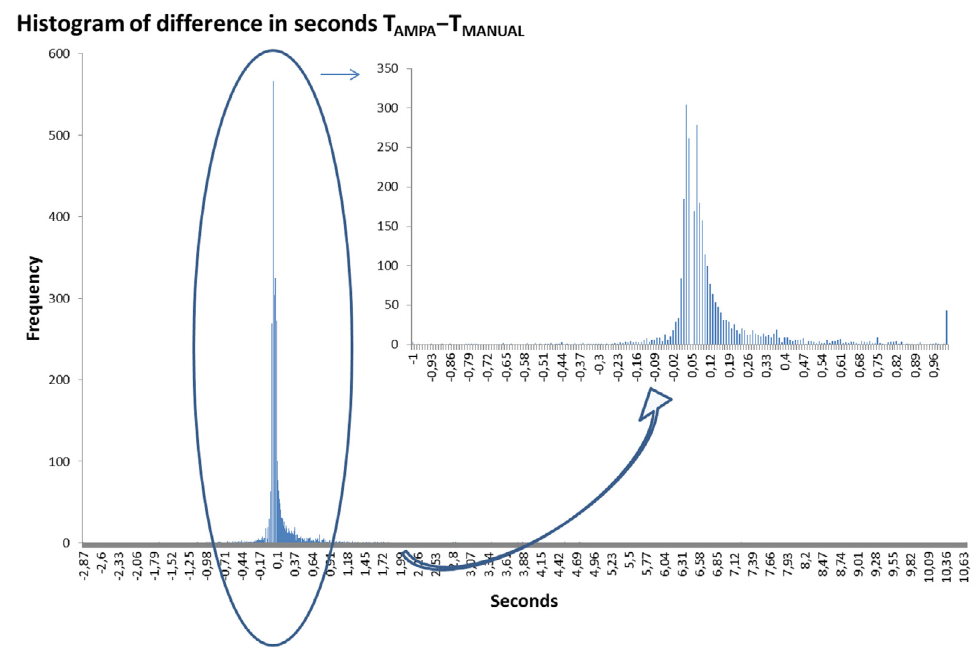
Figure 15. Histogram of differences (in seconds) between automatic P-picks obtained with AMPA and manual picks obtained by experts from the Istituto Nazionale di Geofisica e Vulcanologia, Sezione di Catania - Osservatorio Etneo, Catania, Italy. Comparison performed for 3000 registers obtained from stations of the INGV permanent